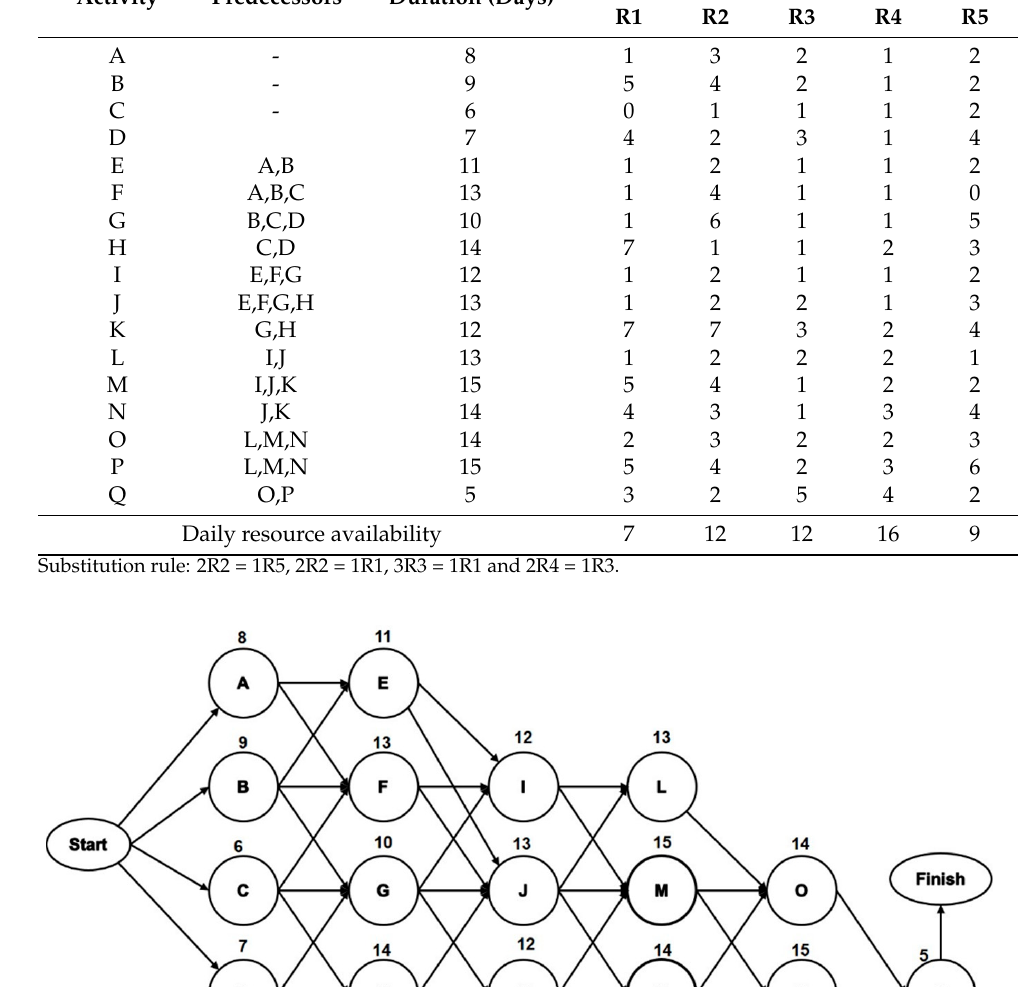
Table 7. Project information for Project C.